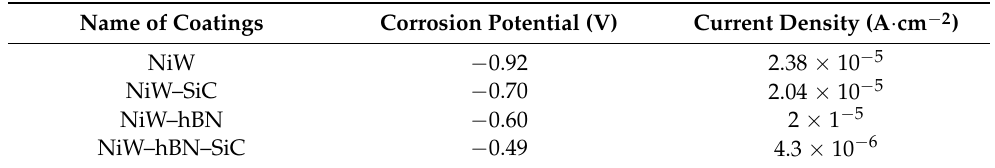
Table 3. Corrosion potential and current density values extracted from potentiodynamic polarization